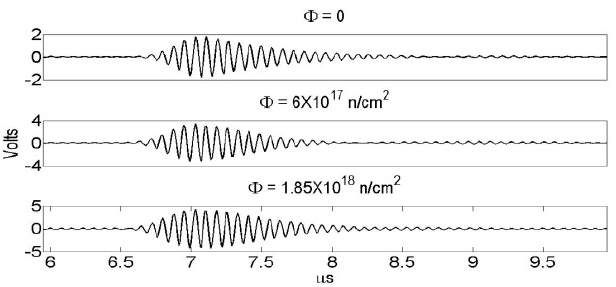
Figure 9. Relative pulse-echo amplitude measured as function of temperature for AlN sample. Note the increase as temperature is raised above 400 °C [31].